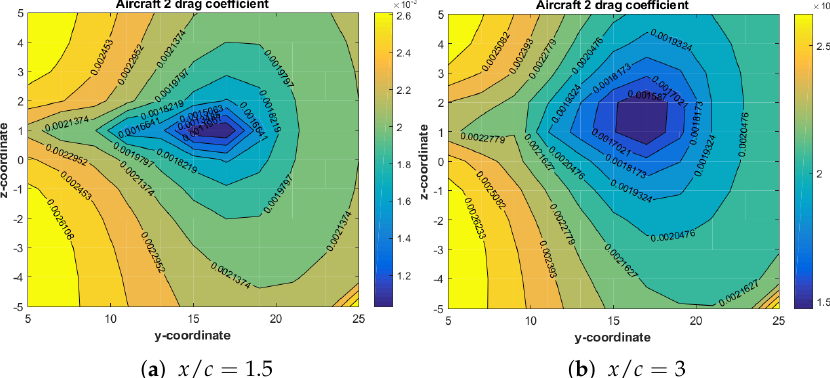
Figure 16. Drag coefficient contours of blended-wing-body configuration in double tandem formation flight of the trailing aircraft on y-z plane at two different stream-wise